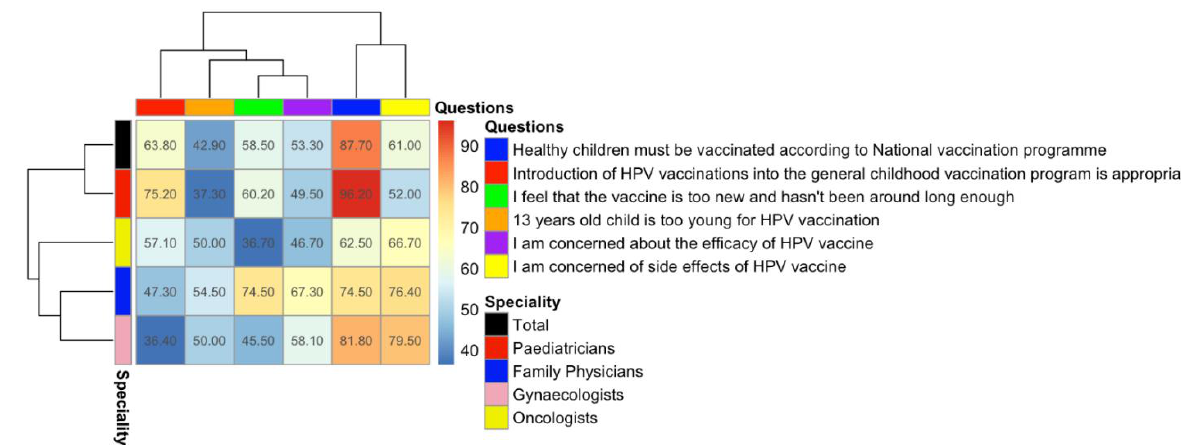
Figure 2. Hierarchy clustering heatmap showing attitudes to HPV vaccine of physicians from different specialities. Number in squares indicates the percentage of who said “ yes ” .